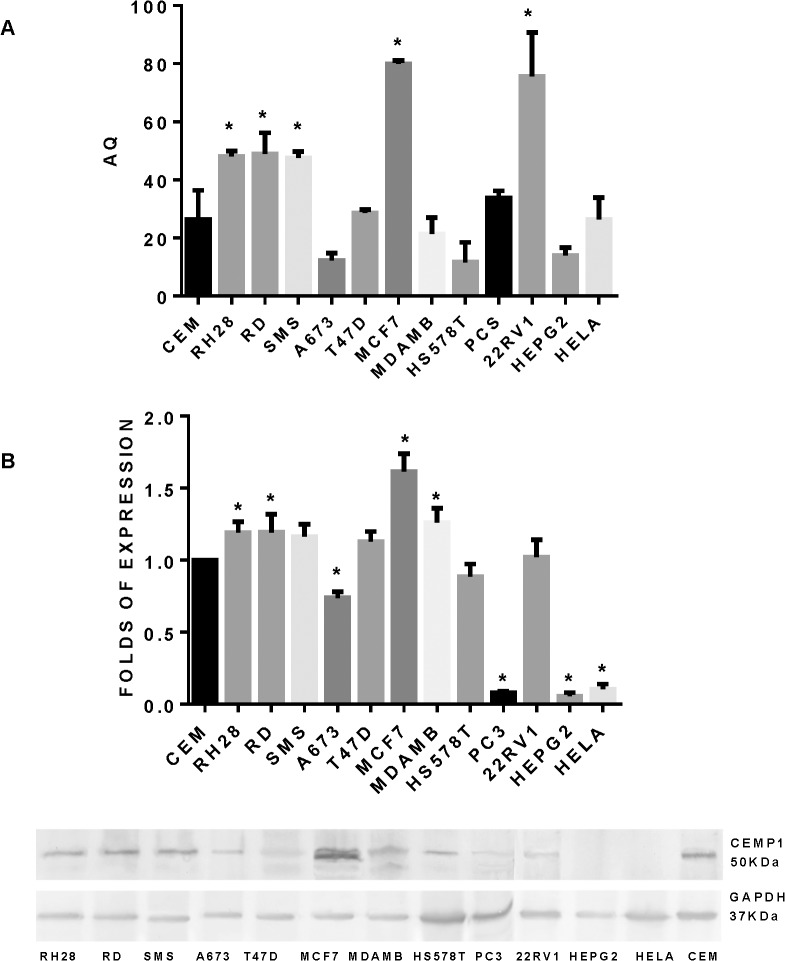
CEMP1 is expressed on cancer cells.CEMP1 expression screening on a variety of human cancer cell lines by qRT-PCR. the mean ± standard deviations are presented (A). Western Blot was developed and Fold of CEMP1 expression compared against cementoblastic-like cell line (CEM) is presented (B).